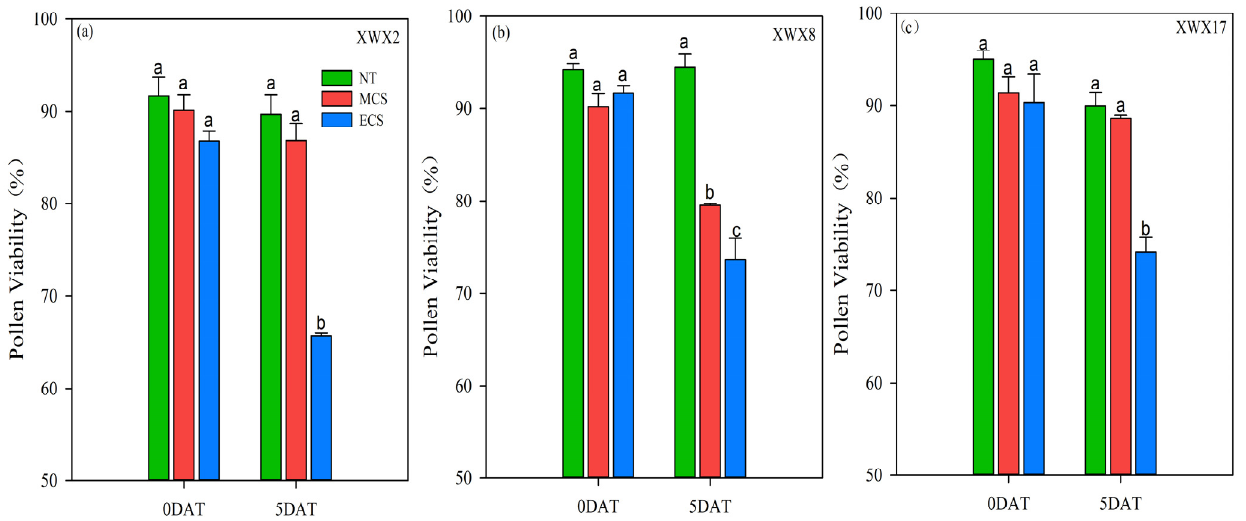
Figure 2. The pollen viability of three inbred late varieties under different temperature treatments. ( a ) XWX2. ( b ) XWX8. ( c ) XWX17. DAT: Days after temperature treatments; XWX2: Xiangwanxian2; XWX8: Xiangwanxian8; XWX17: Xiangwanxian17; NT: Normal temperature control; MCS: Moderate chilling stress; ECS: Extreme chilling stress. Different lowercase letters denote statistical differences among treatments of a cultivar at the 5% level according to LSD test. Error bars above mean indicate standard error ( n =